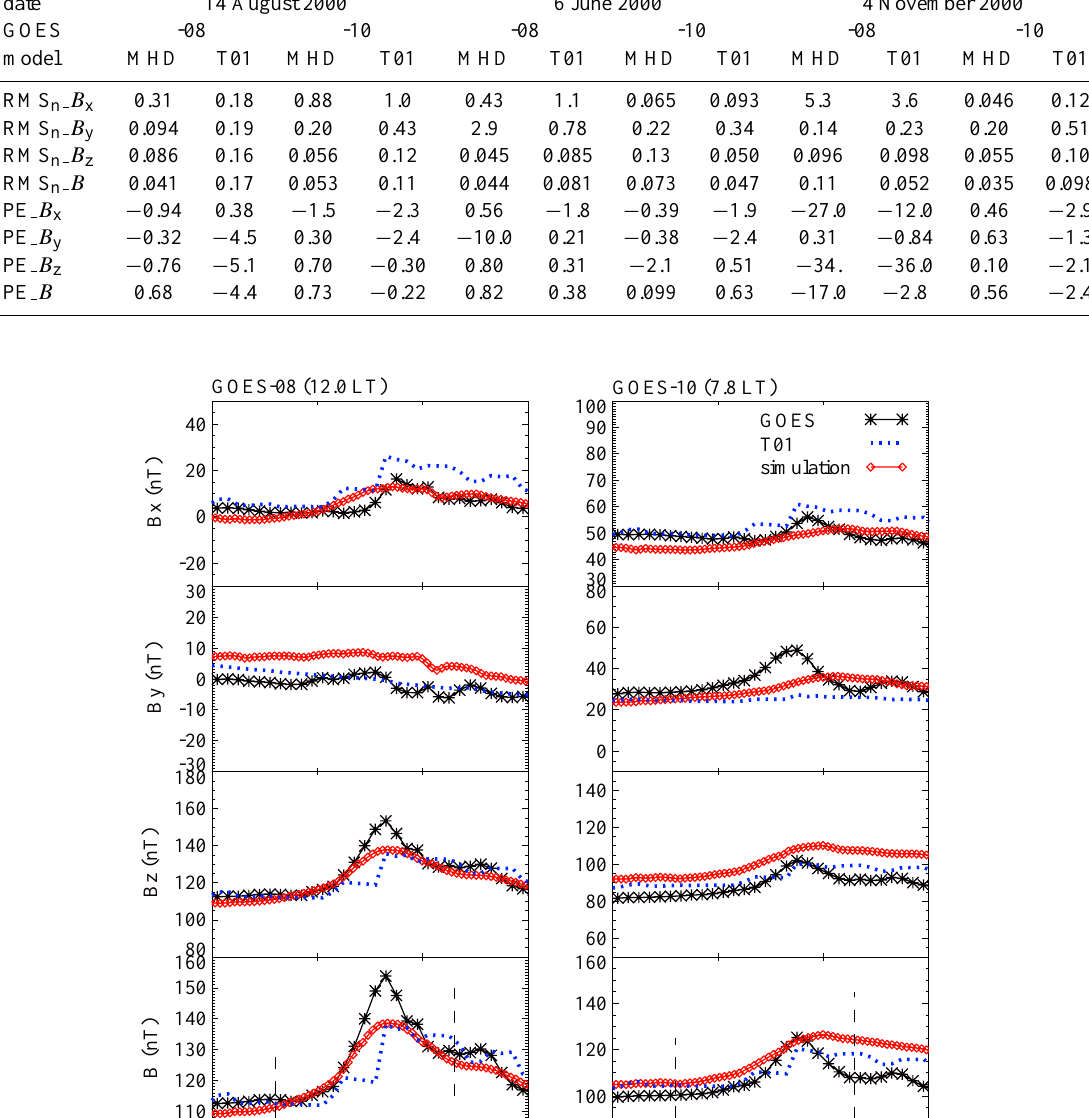
− 0.19, 0.33) GSE with an error of 7.6 ◦ based on the CfA online shock database